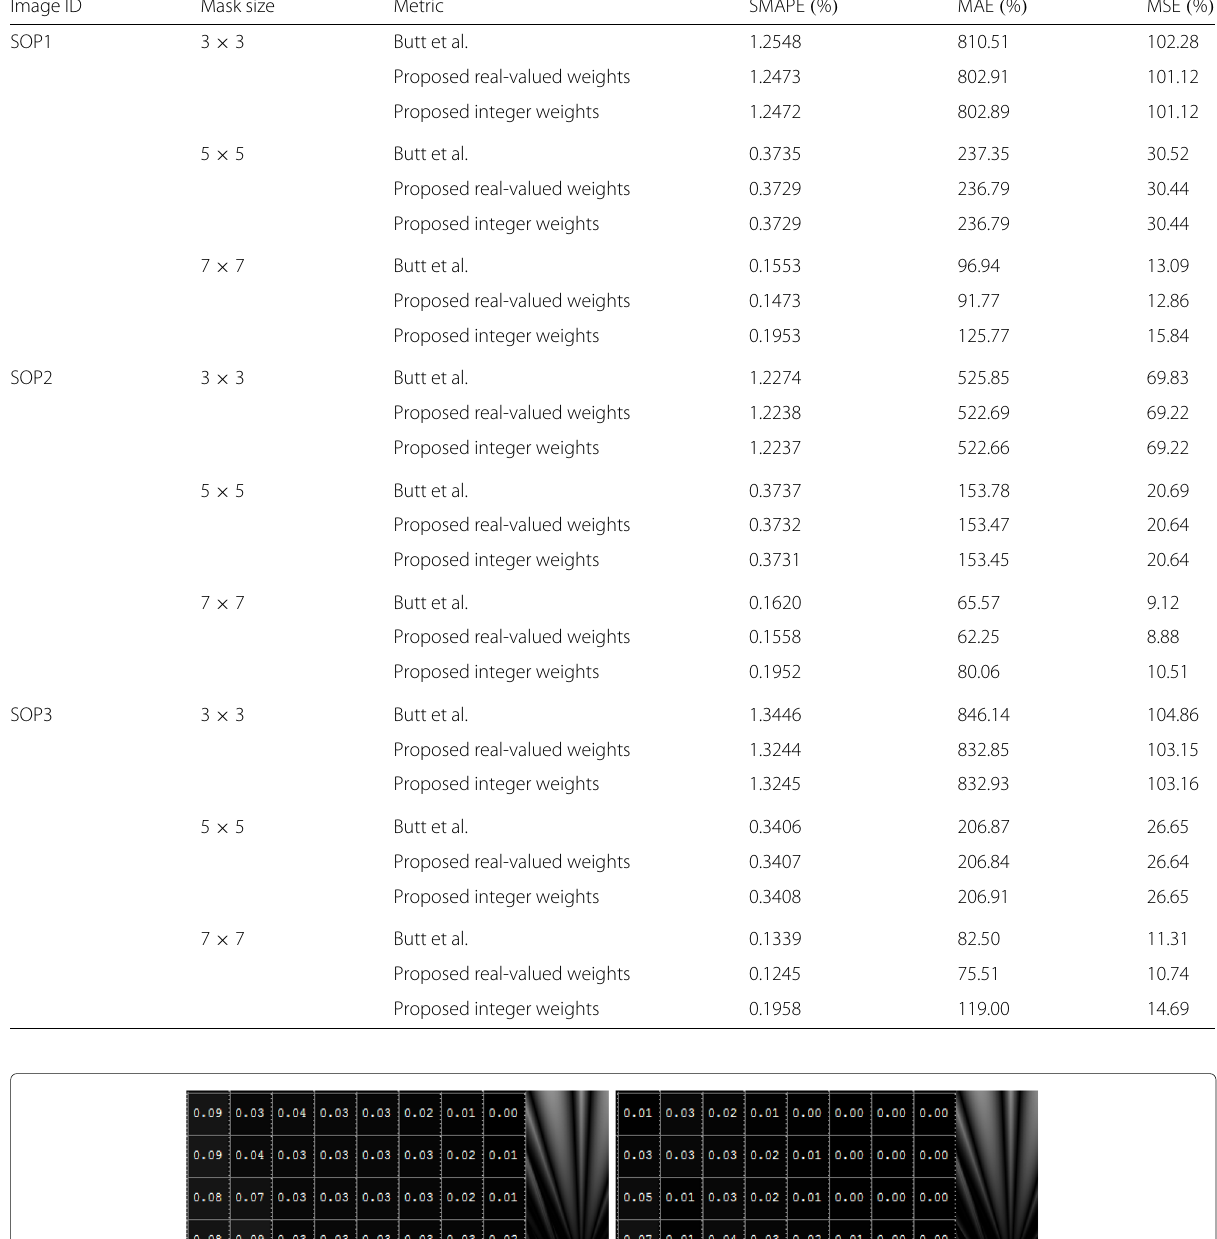
Table 2 Errors generated by chamfer masks applied to real images